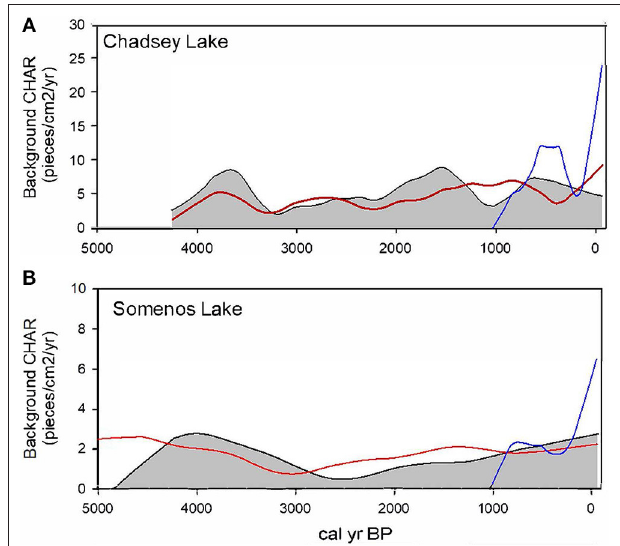
FIGURE 6 | Comparison of background CHAR (pieces/cm 2 /yr) over calibrated years before present (cal yr BP) for composite (black line with shading), AMS 14 C (red line), and surface-only (blue line) sedimentary-charcoal records for (A) Chadsey Lake and (B) Somenos